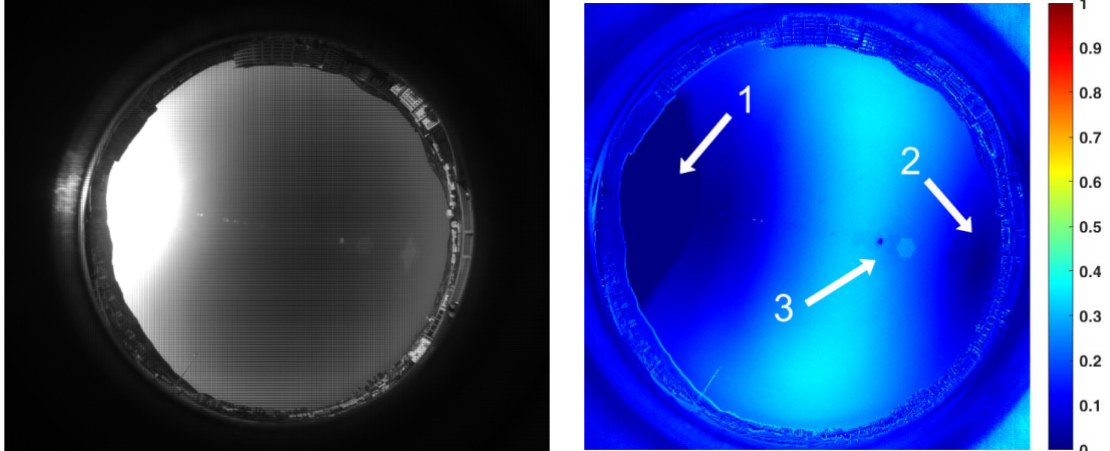
Figure 5. Exposed sky image obtained by the polarization camera and the corresponding polarization degree distribution results.